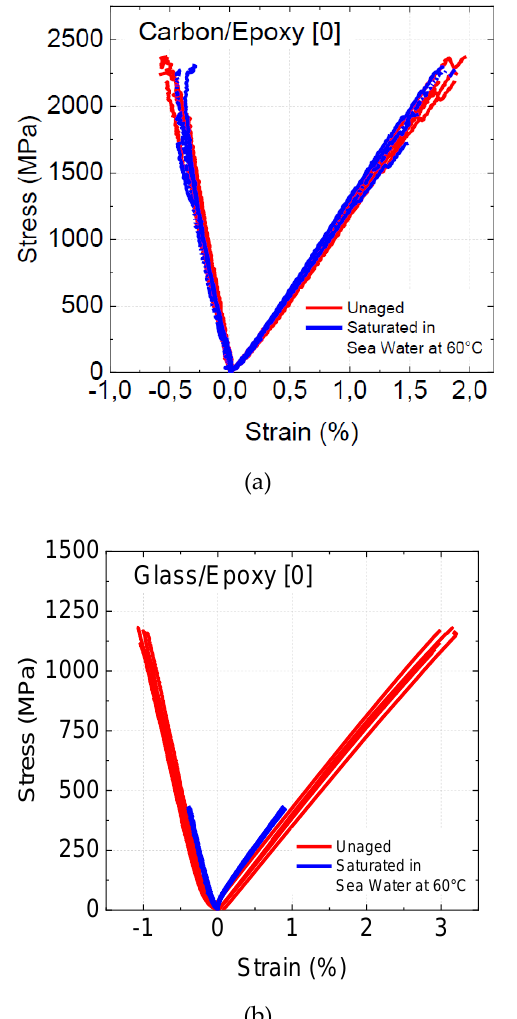
Fig.2. Test results for 0° specimens (a) C/epoxy and (b) glass/epoxy, loaded along the fibre direction both dry and seawater saturated